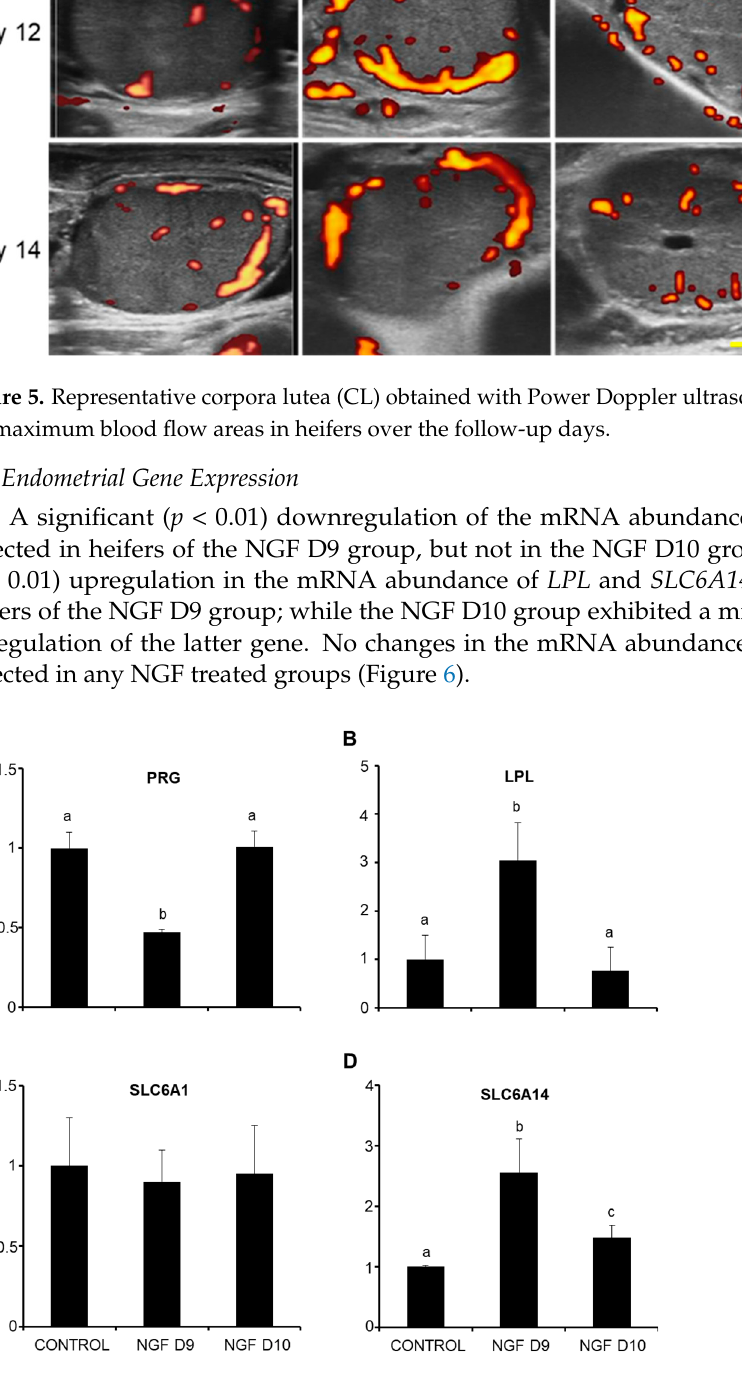
Figure 4. Effect of NGF on luteal function on estrus-synchronized heifers. ( A ) Corpus luteum (CL) diameter profile, ( B ) area of CL vascularization, and ( C ) plasma P4 in heifers treated with PBS (control), NGF D9, or NGF D10. Values are mean ± SEM; values with different superscripts be- tween groups are different ( p < 0.01).